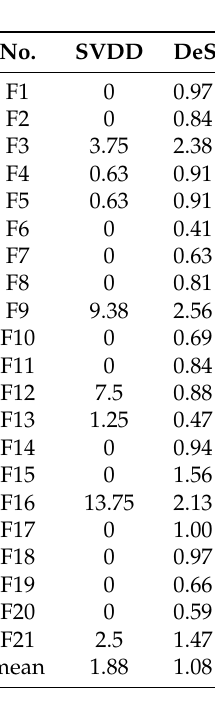
Table 3. False alarming rates (FARs) (%) of the TE process normal data sets by SVDD, DeSVDD and